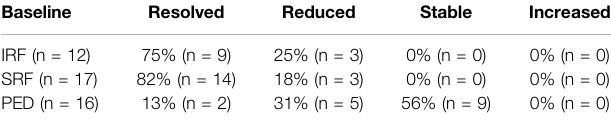
TABLE 3 | Analysis of the OCT parameters of